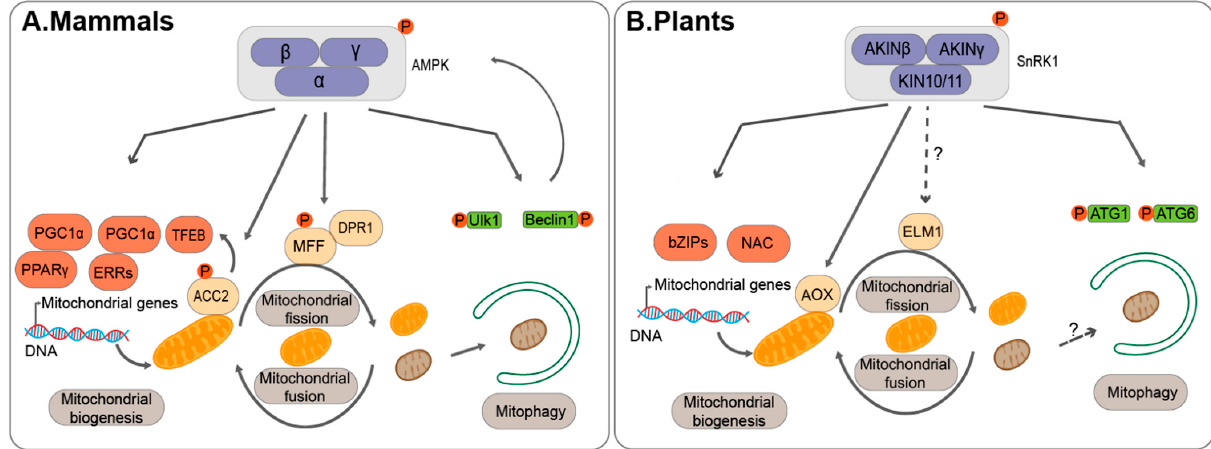
Figure 2. Regulation of mitochondrial homeostasis by AMPK/SnRK. ( A ) In mammals, upon energy stress, AMPK phos- phorylates several transcription regulators essential for mitochondrial biogenesis gene expression, including peroxisome proliferator-activated receptor- γ (PPAR γ ) co-activator 1 α (PGC1 α ), which activates mitochondrial biogenesis genes through interaction with PPAR γ or oestrogen-related receptors (ERRs) [99–101]. Meanwhile, the transcription factor EB (TFEB), is also activated by AMPK to further induce PGC1 α expression upon binding to their promoter region [102]. Mitochondrial outer membrane proteins, including Acetyl-CoA carboxylase 2 (ACC2) and mitochondrial fission factor (MFF), have also been identified as AMPK substrates [103,105]. In addition, AMPK also activates core ATG genes (e.g., ULK1, and Beclin1), which further phosphorylates downstream regulators in mitophagy [106–111,113–118]. ( B ) In plants, SnRK1 phosphorylates ATG1 and ATG6 [121–123]. In addition, SnRK1 also activates NAC transcription factor (NAC) and basic leucine zipper transcription factors (bZIPs), which are involved in regulating mitochondrial gene expression [124–127]. However, whether SnRK1 phosphorylates mitochondrial fusion/fission regulators (e.g., elongated mitochondria1, ELM1) is still unknown (dashed lines).